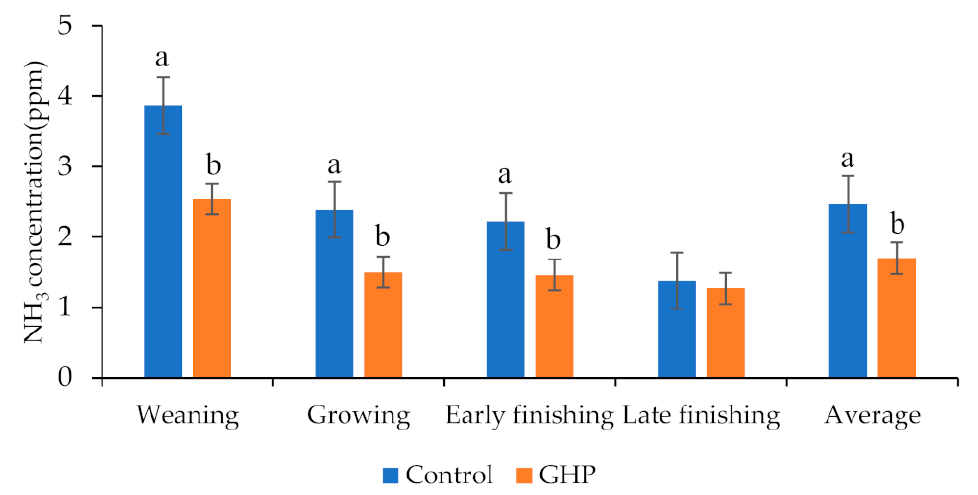
Figure 5. Effect of the GHP cooling mode on the ammonia (NH 3 ) concentration. The data are presented as the mean ± SEM. a,b Values with different superscripts within the same bars differ significantly ( p <